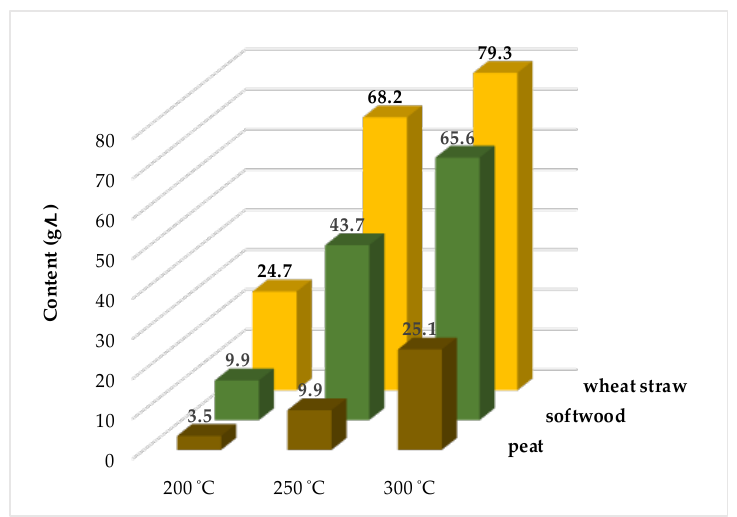
Figure 4. Total content of organic acids in the distillates that were recalculated on the acetic acid content. The concentration of acids in the different distillates was increased in the range: peat < softwood < wheat